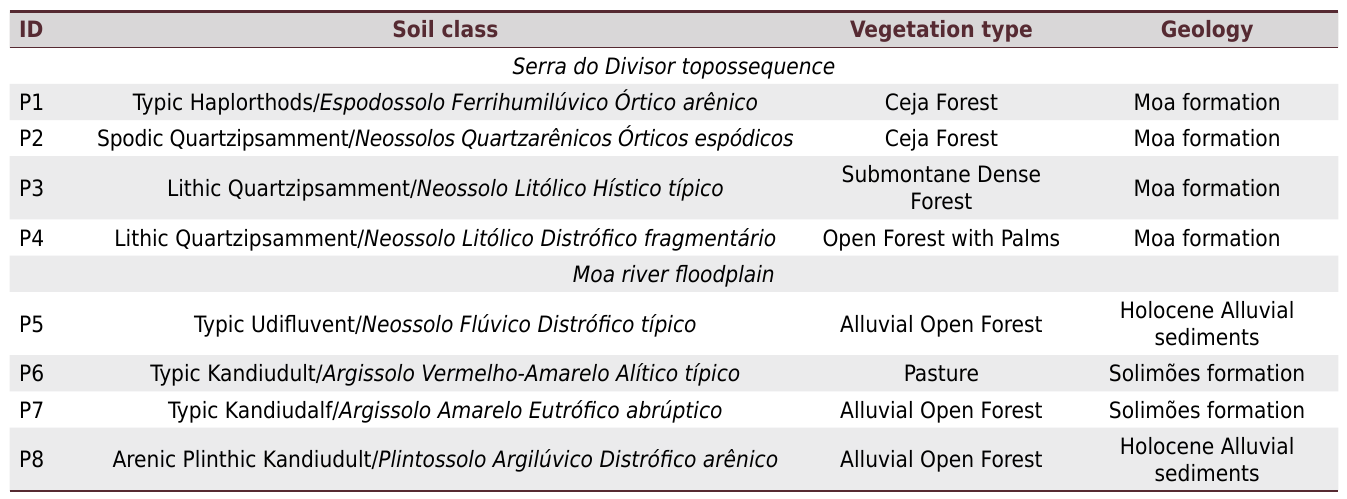
Table 1. General characteristics of the studied soils at the Serra do Divisor National Park, State of Acre,